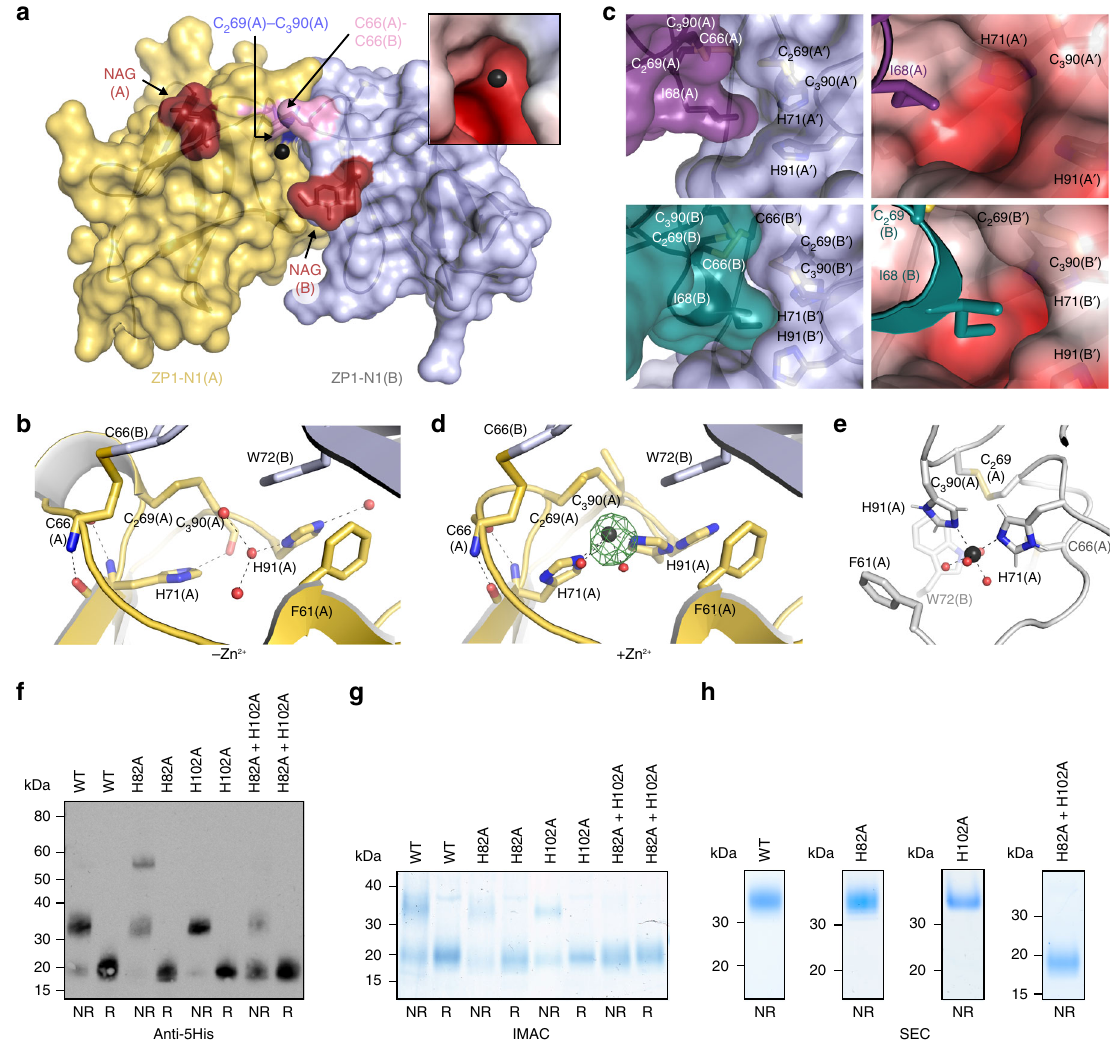
Fig. 8 Role of a conserved ZP1-N1 His pair in Zn 2 + binding and homodimerisation. a Surface representation of the structure of the deglycosylated cZP1-N1 homodimer in the crystal soaked with Zn(OAc) 2 , highlighting the position of the Zn 2 + ion bound to H71(A) and H91(A) (black sphere) relative to the protein subunits, two proximal disulphide bonds and N-acetylglucosamine (NAG) residues attached to N65. The A subunit of the homodimer is coloured gold according to Fig. 5, whereas subunit B is shown in lilac. The inset shows a detailed view of the region around the Zn 2 + , coloured by electrostatic potential using a gradient from red ( − 4 kT e − 1 ) to blue ( + 4 kT e − 1 ) through white (0 kT e − 1 ). b Details of the asymmetric interface of the cZP1-N1 homodimer, as observed in the native crystal of the deglycosylated protein. Selected amino acids are shown as sticks, with hydrogen bonds indicated by dashed lines. c Surface representation of the symmetric interface of glycosylated cZP1-N1 (chain A, top left panel; chain B, bottom left panel), showing the position of H71 and H91 relative to I68. Notably, the H71/H91 pocket of the A ′ subunit is more accessible than that of B ′ , due to apparent fl exibility of the relatively small symmetric interface. The right panels, which are rotated by 30 degrees over the y- axis compared with the left ones, show zoomed views of the symmetric interfaces around I68(A) and I68(B), with the surface of the A ′ and B ′ molecules coloured by electrostatic potential as in the inset of panel a . d Details of the asymmetric interface of deglycosylated cZP1-N1, as observed in the Zn 2 + -soaked crystal. The green mesh is an anomalous difference map calculated at λ = 1.2825 Å and contoured at 6 σ . e 100-ns MD simulation snapshot of the Zn 2 + - binding site shown in panel a . H71 and H91, together with four water molecules, coordinate the zinc ion during the whole simulation time (mean Zn-His N distance 2.22 ± 0.06 Å; mean Zn – H 2 O O distance 2.10 ± 0.05 Å). f Anti-5His immunoblot analysis of wild-type (WT) and His mutant hZP1-N1 constructs secreted by HEK293T cells (100 μ L medium). g , h Coomassie-stained SDS-PAGE analysis of IMAC (panel g ) and SEC (panel h ) fractions from the puri fi cation of the same constructs shown in panel f . The SEC pro fi les corresponding to panel h are reported in Supplementary Fig. 6 Preparation of soluble ZP glycoproteins from proteolytically degraded 50mM Na-HEPES pH 7.8, 150 mM NaCl, 0.1% (v v − 1 ) SDS, 0.5% (v v − 1 ) sodium chicken egg coat . Egg coats were isolated from the F1 oocytes of laying white deoxycholate, 1% (v v − 1 ) Triton X-100 and protease inhibitors (cOmplete mini EDTA-free protease inhibitor cocktail; Roche) were added to one well and the plate leghorn hens; sperm and sperm protease were prepared from ejaculated semen incubated overnight at 4 °C. Lysate samples were recovered by scraping cells in the using gentle centrifugation and nitrogen cavitation, respectively 44 . In total, 100mg presence of SDS-PAGE loading buffer. In all, 40 µL of cell lysate was boiled and of isolated egg coat (wet weight) was suspended in 1mL of PBS by ultrasonica- separated by SDS-PAGE for immunoblot analysis. tion 31 and then mixed with the sperm protease preparation. The reaction mixture Deglycosylation experiments in reducing conditions were performed with PNGase was kept at 39°C for 20h and centrifuged at 16,000 x g for 5min. The supernatant F (New England Biolabs), according to the manufacturer ’ s instructions; for analysing was 0.45- μ m fi ltered and injected into a HiPrep 16/60 Sephacryl S-300 HR column deglycosylation products in non-reducing conditions, DTT-containing Glycoprotein (GE Healthcare). SEC elution pro fi les were monitored by measuring absorbance at λ = 280 nm, and both the ~35kDa and ~21 kDa N-terminal fragments of cZP1 Denaturing Buffer was replaced with 10mM Na-HEPES pH 7.5, 1% (v v − 1 ) SDS. NATURE COMMUNICATIONS| (2019) 10:3086